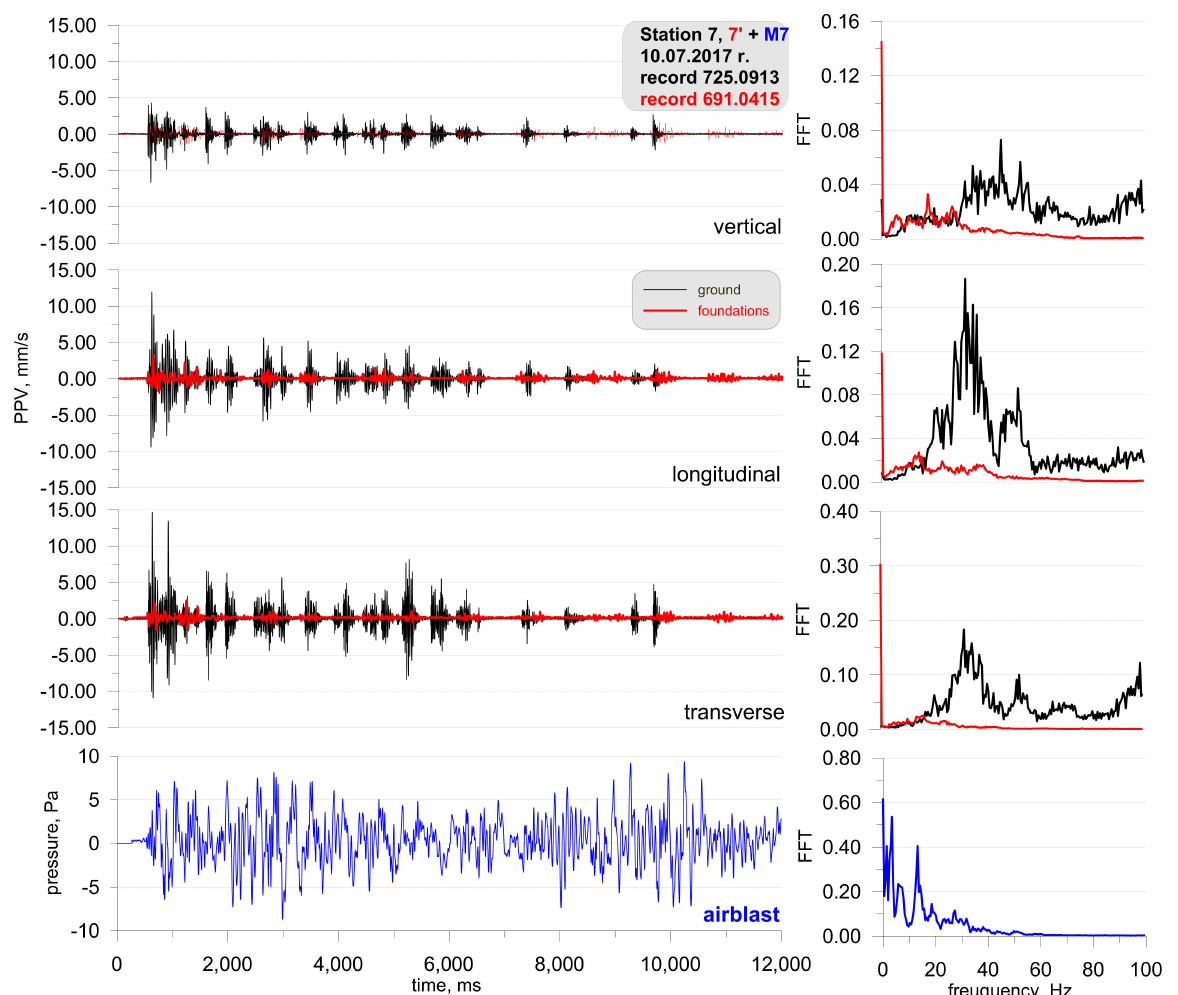
Figure 17. Seismogram of the vibration of the ground, foundation, and recording of airblast wave pressure combined with the analysis of the FFT-Station